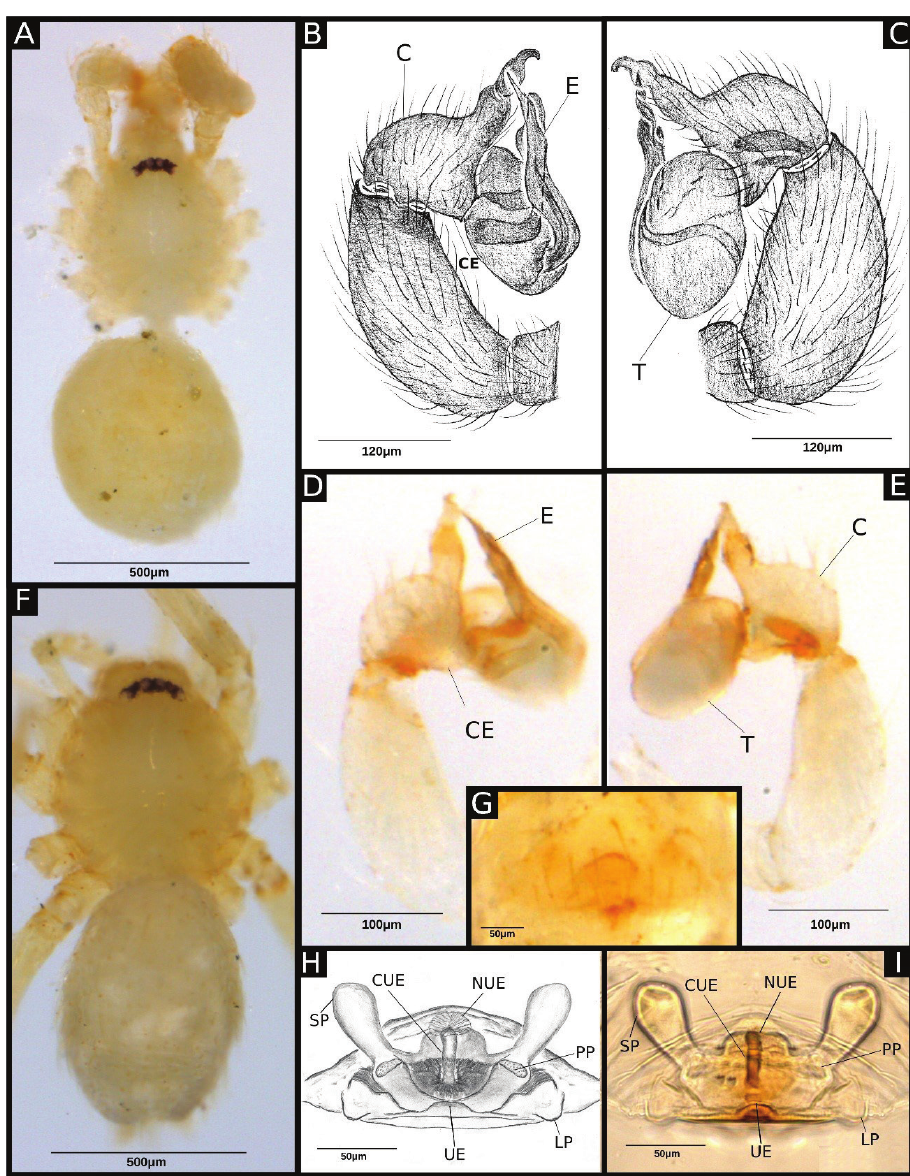
Figure 9. Ochyrocera monica sp. nov., male (IBSP 196681) A habitus, dorsal view B palp, prolateral view C same, retrolateral view D same, retrolateral view E same, prolateral view F habitus, dorsal view, female (IBSP 196676) G epigynal plate, ventral view H internal genitalia, dorsal view I same, enzyme cleared, dorsal view. Abbreviations: C, cymbium; CE, cymbial extension; E, embolus; LP, lateral pockets; NUE, neck of uterus externus; PP, pore-plate; SP, spermathecae; T, tegulum; UE, uterus